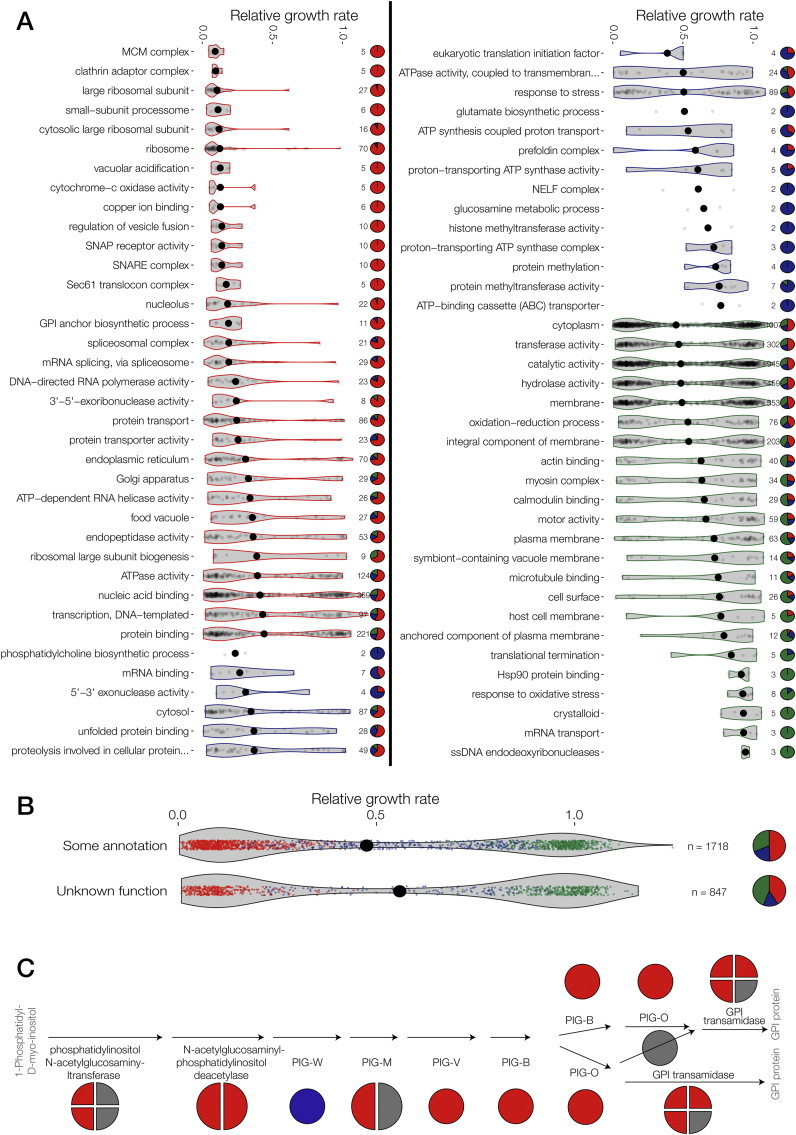
Analysis of Gene Functions Associated with Phenotypes, Related to Figure 6 and Table S7(A) GO terms significantly enriched for genes with essential, slow or dispensable phenotype (p < 0.05). See Table S7 for genes in all significant categories.(B) Phenotypes of genes of unknown function. In both panels violin plots show RGRs, with the median indicated by a black dot. Gene numbers per category are given next to pie charts showing phenotype distributions. Color scheme as in Figure 2.(C) Phenotypes mapped onto genes involved in GPI-anchor biosynthesis.